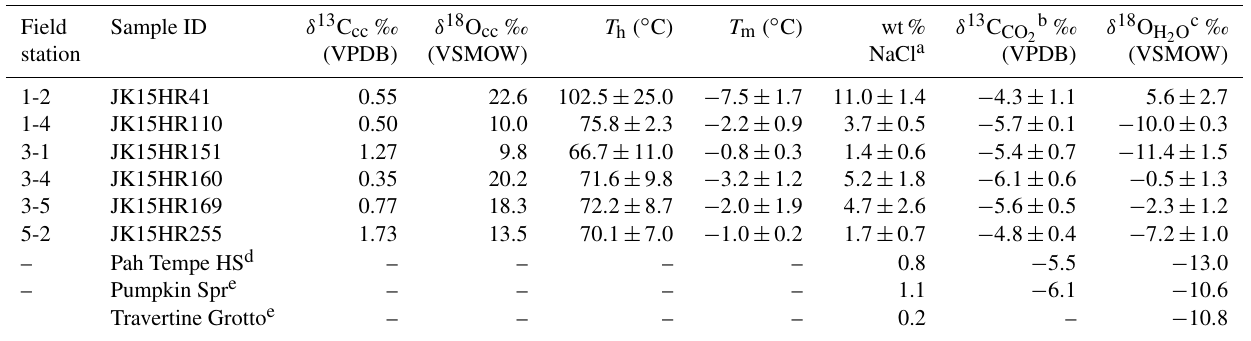
Table 1. Calculated paleofluid δ 13 C and δ 18 O from calcite C and O stable isotopes and microthermometry.